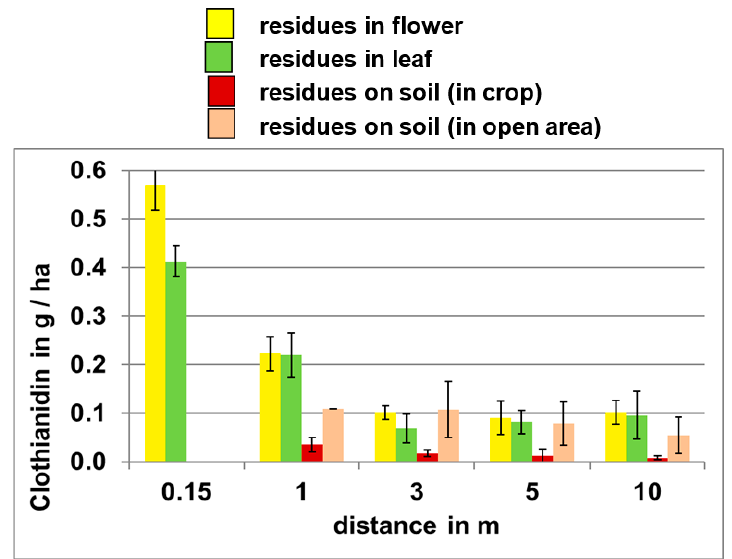
Figure 3. Clothianidin residue (g/ha) in oilseed rape crop or soil at various distances from the crop edge following sowing of corn (2010) [28].